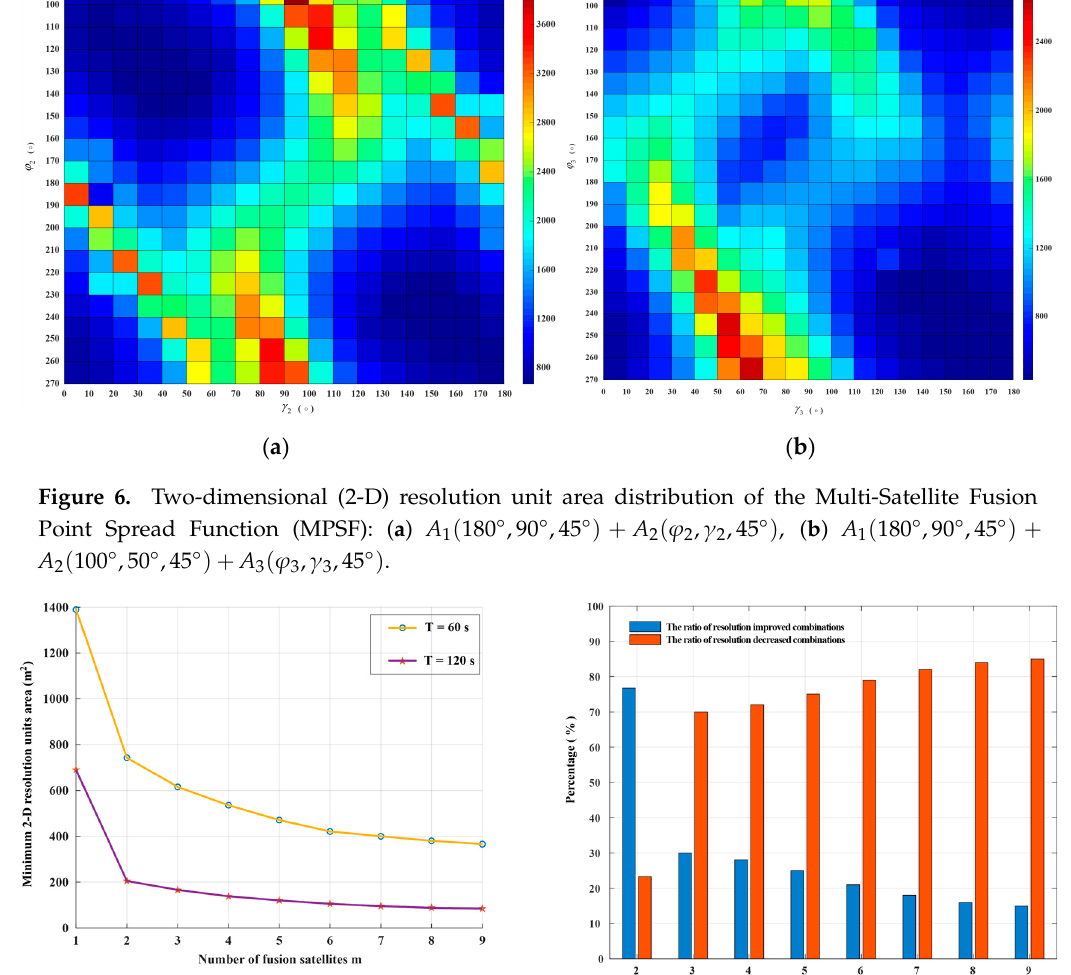
) A , the area is reduced by 55.7%. It shows that the fusion of three-satellite can obtain optimal solution (743 m 2 ), only about 30% 2-D resolution of MPSF ( m = 3) has been improved in varying degrees, and about 70% 2-D resolutions were deteriorated. The results show that the three- satellite fusion has higher requirements for the geometric configuration of the satellites participating in the fusion than the dual-satellite fusion, and the complexity of satellite selection is further improved, but the performance improvement efficiency is reduced. Figure 7. The optimal 2-D resolution of MPSF ( m ≤ 9), ( a ) is the variation of the minimum 2-D resolution units area with m ( T = 60 s and T = 120 s), ( b ) is the ratio of resolution increase and decrease compared to the optimal resolution of m − 1 ( T = 60